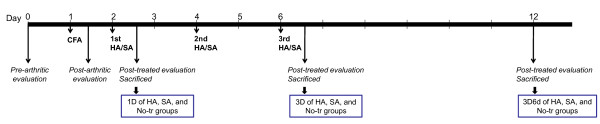
Experimental design of the sequence of events for the entire course of the experiment. After evaluations that included measurements of paw edematous swelling and pain threshold, the animals were sacrificed for histology and immunohistochemistry. 1D, one dose; 3D, three doses; 3D6d, follow-up at the 6th day after three doses; CFA, complete Freund's adjuvant; HA, hyaluronan; No-tr, no treatment; SA, saline.